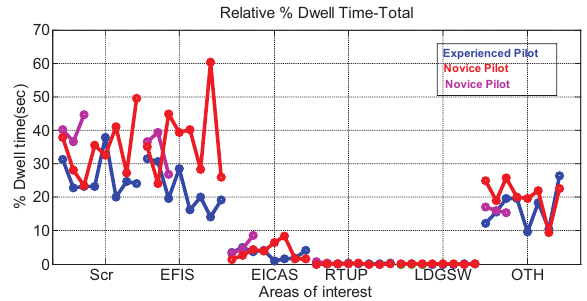
Figure 5. PDT of all nominal cases